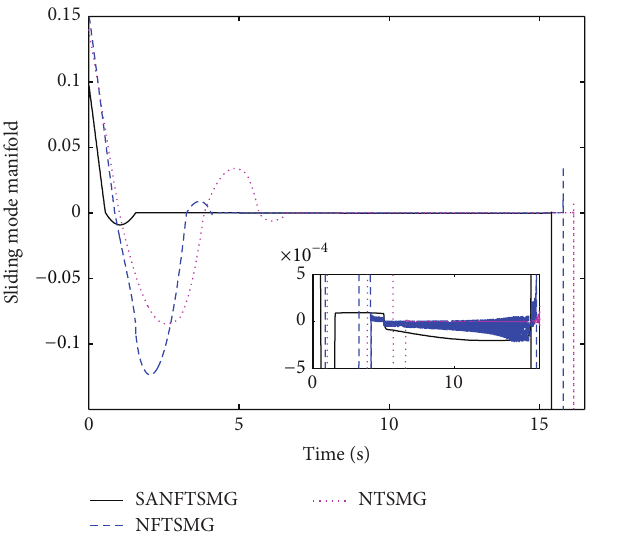
Figure 12: Trajectories of missile and target (Case 3).